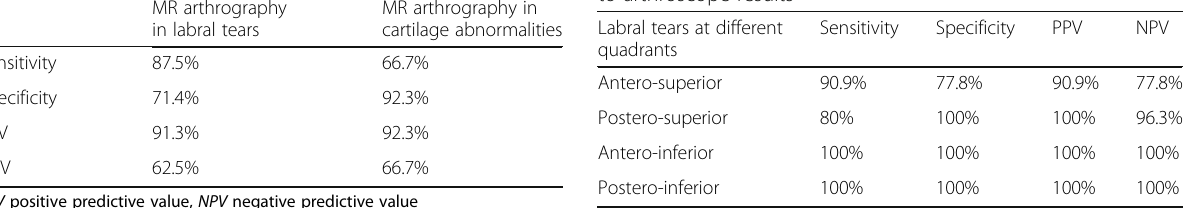
Table 5 The diagnostic performance parameters (sensitivity, specificity, PPV, and NPV) of MR arthrography for detection